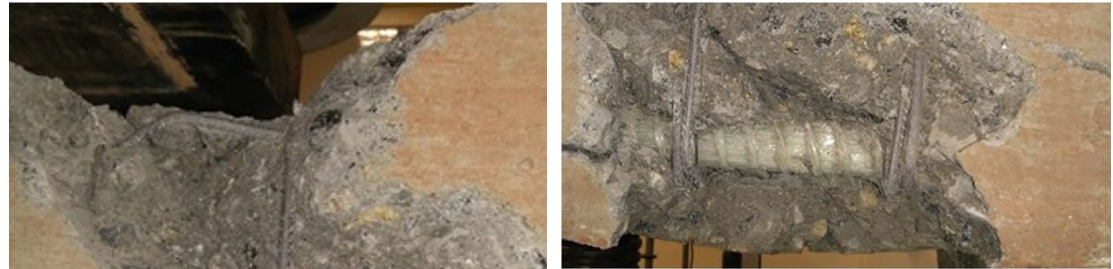
Figure 12. a Crushed concrete. b. Intact GFRP bars.